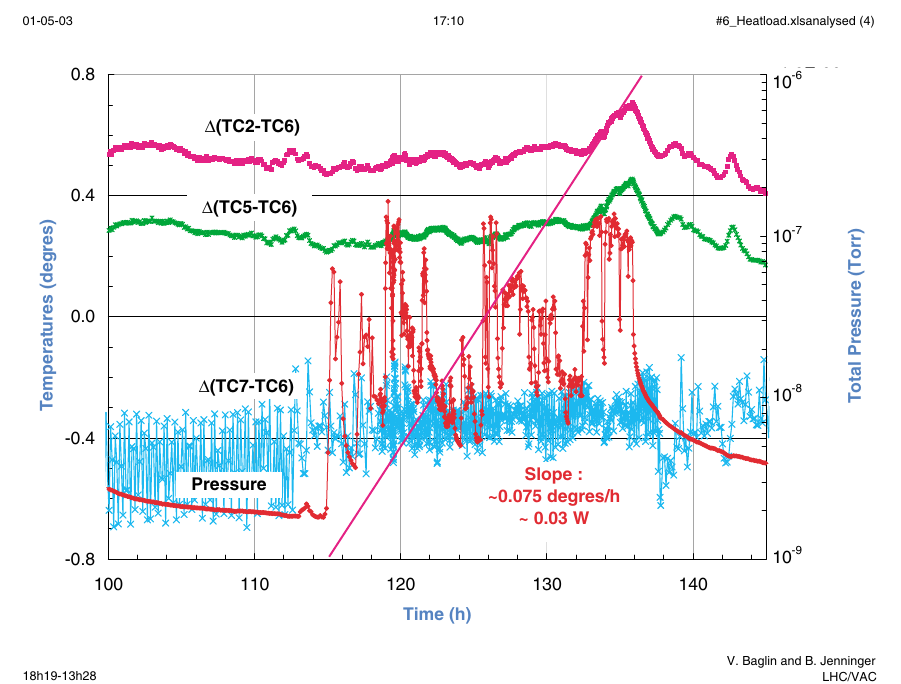
FIG. 4. (Color) Relative temperature and pressure observations when a LHC-type beam of three consecutive batches of 72 bunches with 5 (cid:2) 10 10 protons = bunch (cid:1) 1 was circulating in the